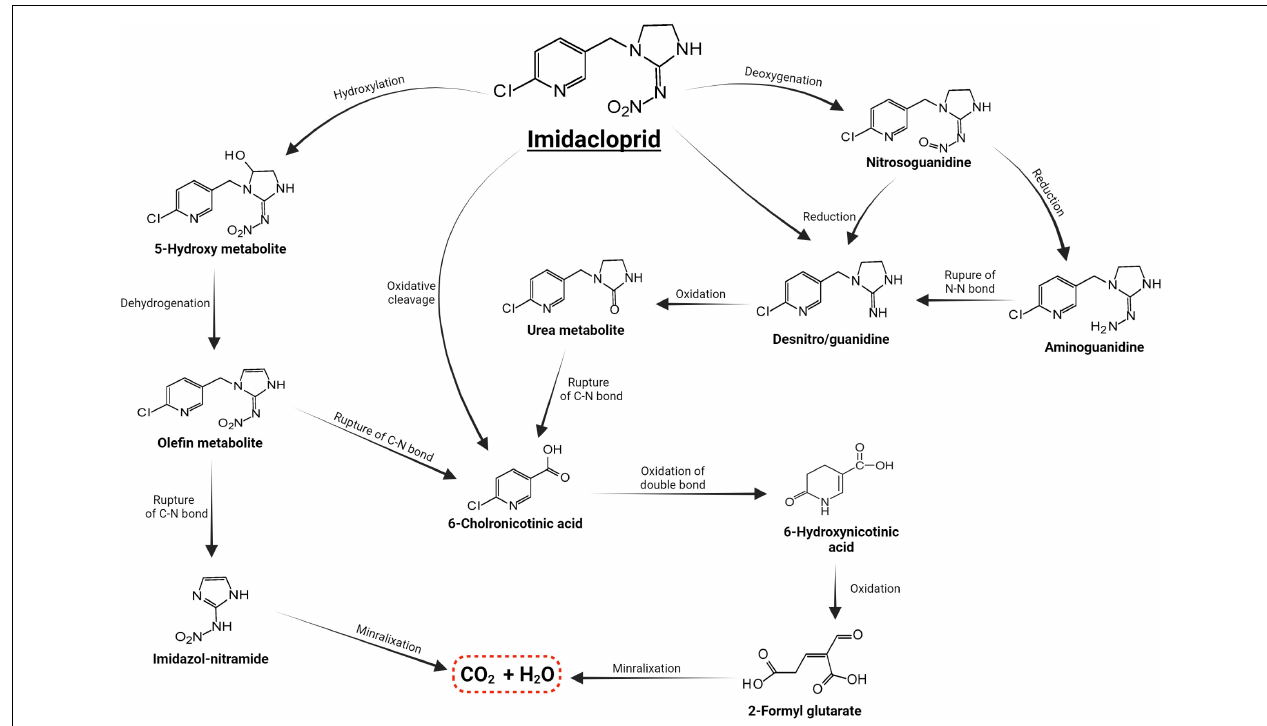
FIGURE 4 | Metabolic routes for bacterial degradation of the insecticide imidacloprid (Pang et al., 2020a).